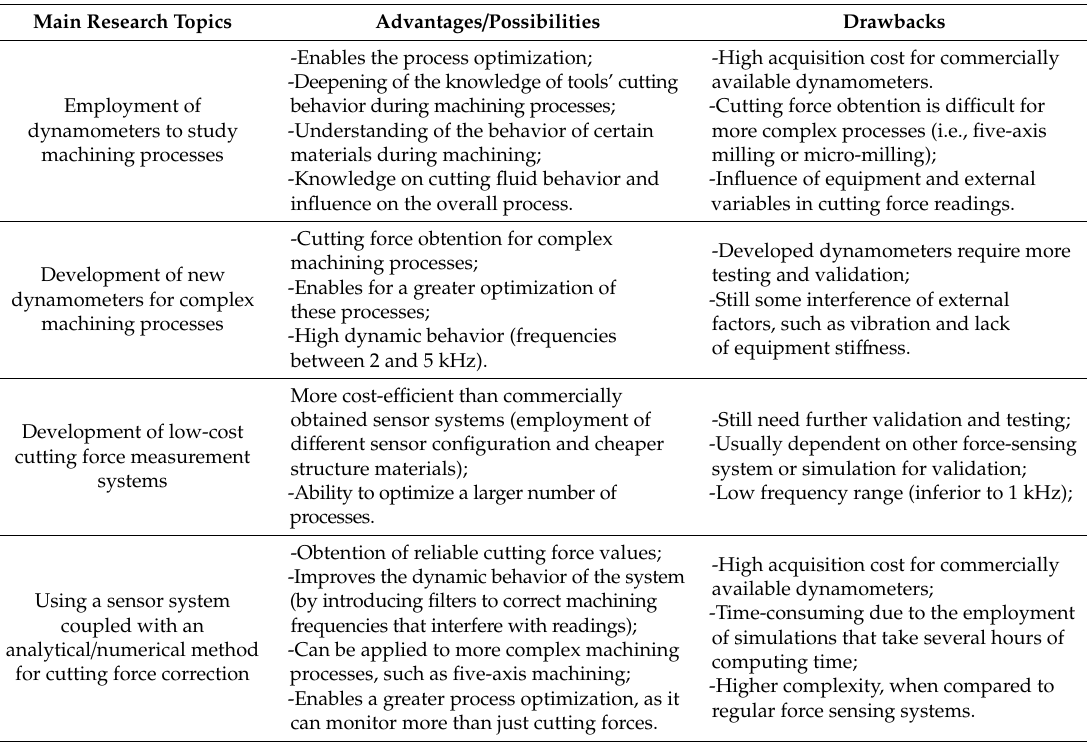
Table 2. Main research topics of cutting force measurement